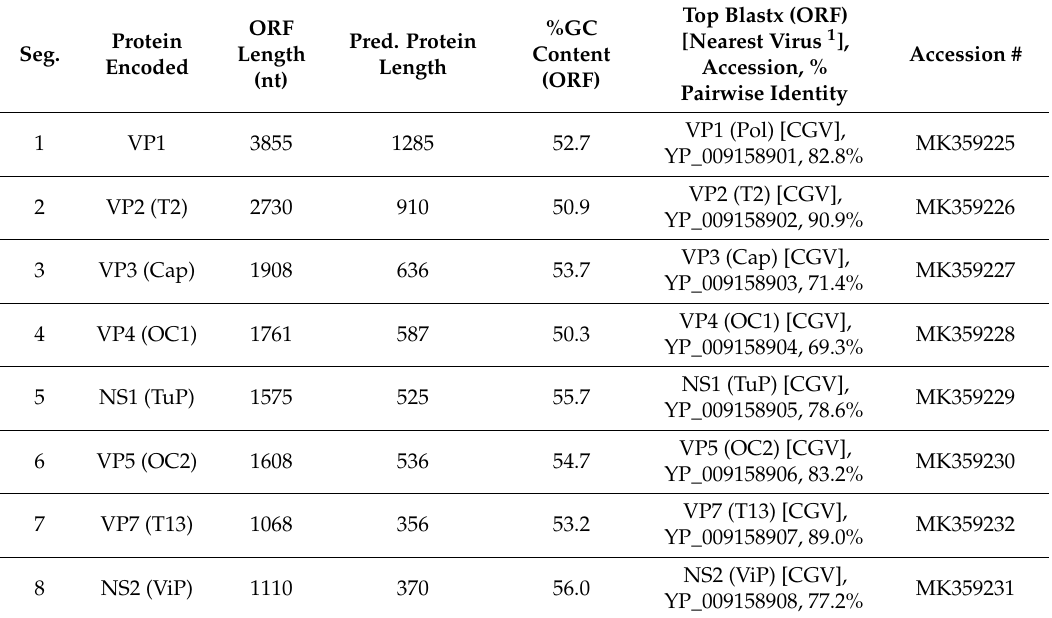
Table 3. Genetic analysis of FOMV genome segments, predicted ORFs, and predicted proteins.